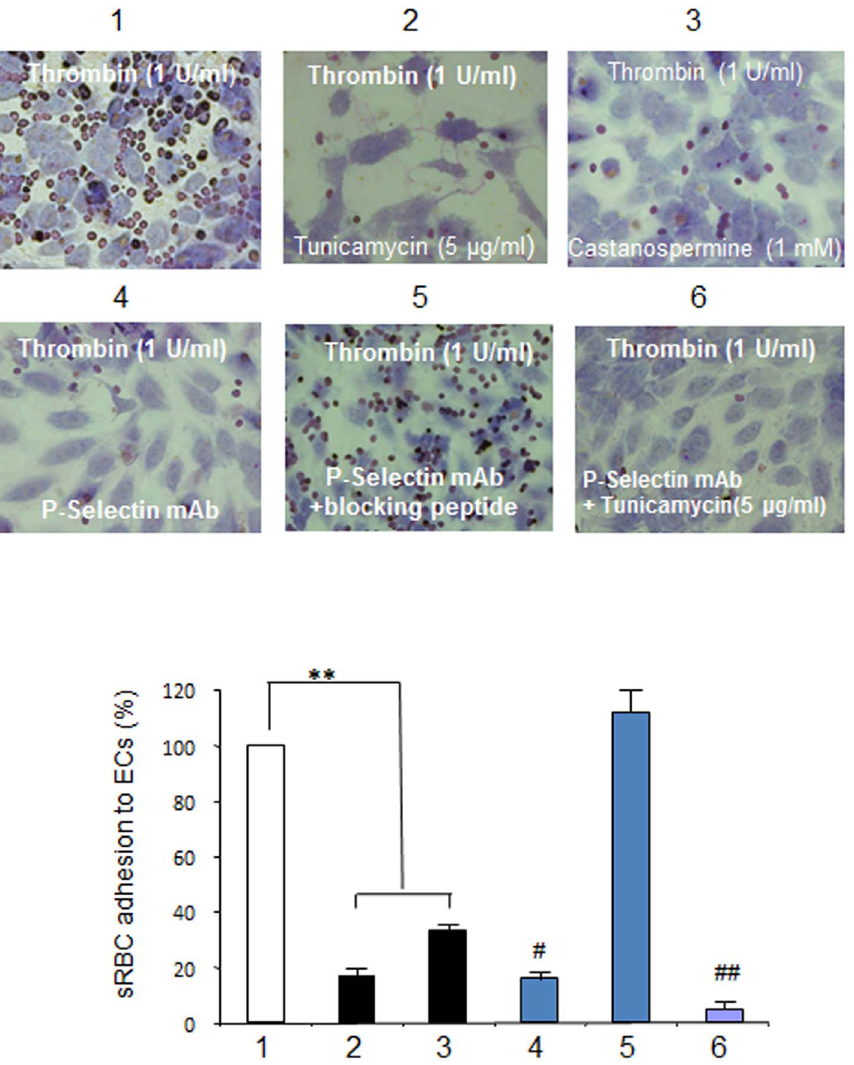
Figure 5. Comparison of sRBC adhesion inhibition by glycosylation inhibitors and P-selectin monoclonal antibody. HUVECs that were cultured as described in Materials and Methods were pretreated with saline or glycosylation inhibitors for 48 hours and stimulated with 1 U/mL thrombin. sRBCs were isolated from SCD patients and added to HUVECs. To examine the inhibition of sRBC adhesion, P-selectin monoclonal antibody was added to HUVECs prior to the addition of sRBCs. To inactivate P-selectin monoclonal antibody, the antibody was premixed with blocking peptide. Lanes: 1, HUVECs stimulated with 1U/mL thrombin; 2, HUVECs pretreated with 5 m g/mL tunicamycin; 3, HUVECs pretreated with 1 mM castanospermine; 4, HUVECs added with P-selectin monoclonal antibody; 5, HUVECs added with P-selectin monoclonal antibody premixed with blocking peptide; 6, HUVECs pretreated with 5 m g/mL tunicamycin and further added with P-selectin monoclonal antibody. **, p , 0.0001; ## , p , 0.01 (vs lanes 2 &